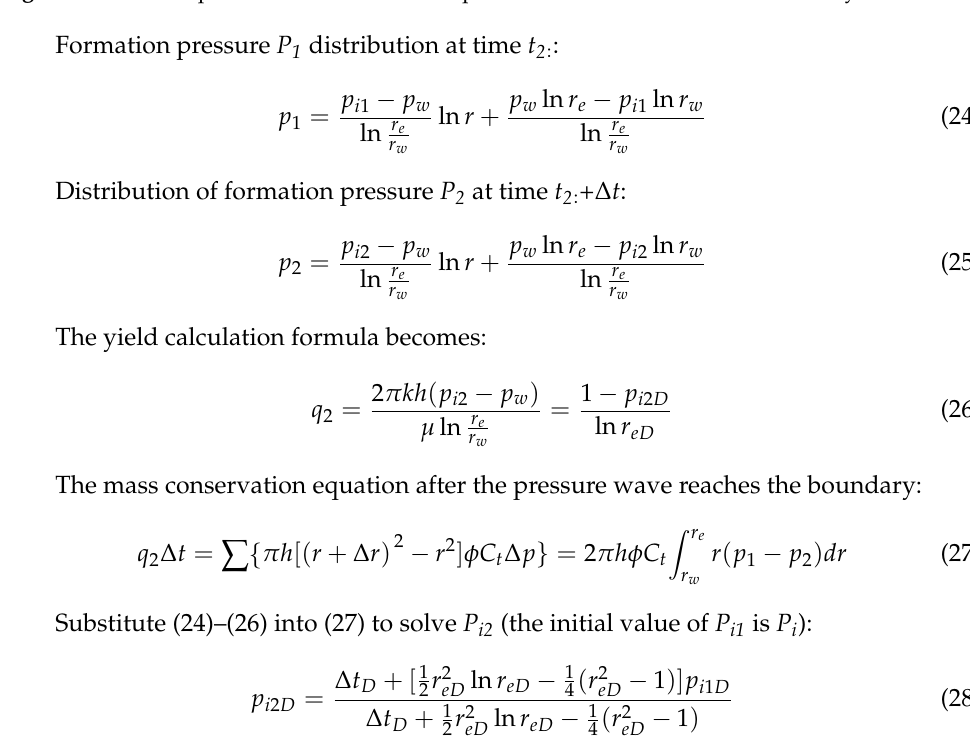
Figure 3. Reservoir pressure distribution after pressure arrived at the closed